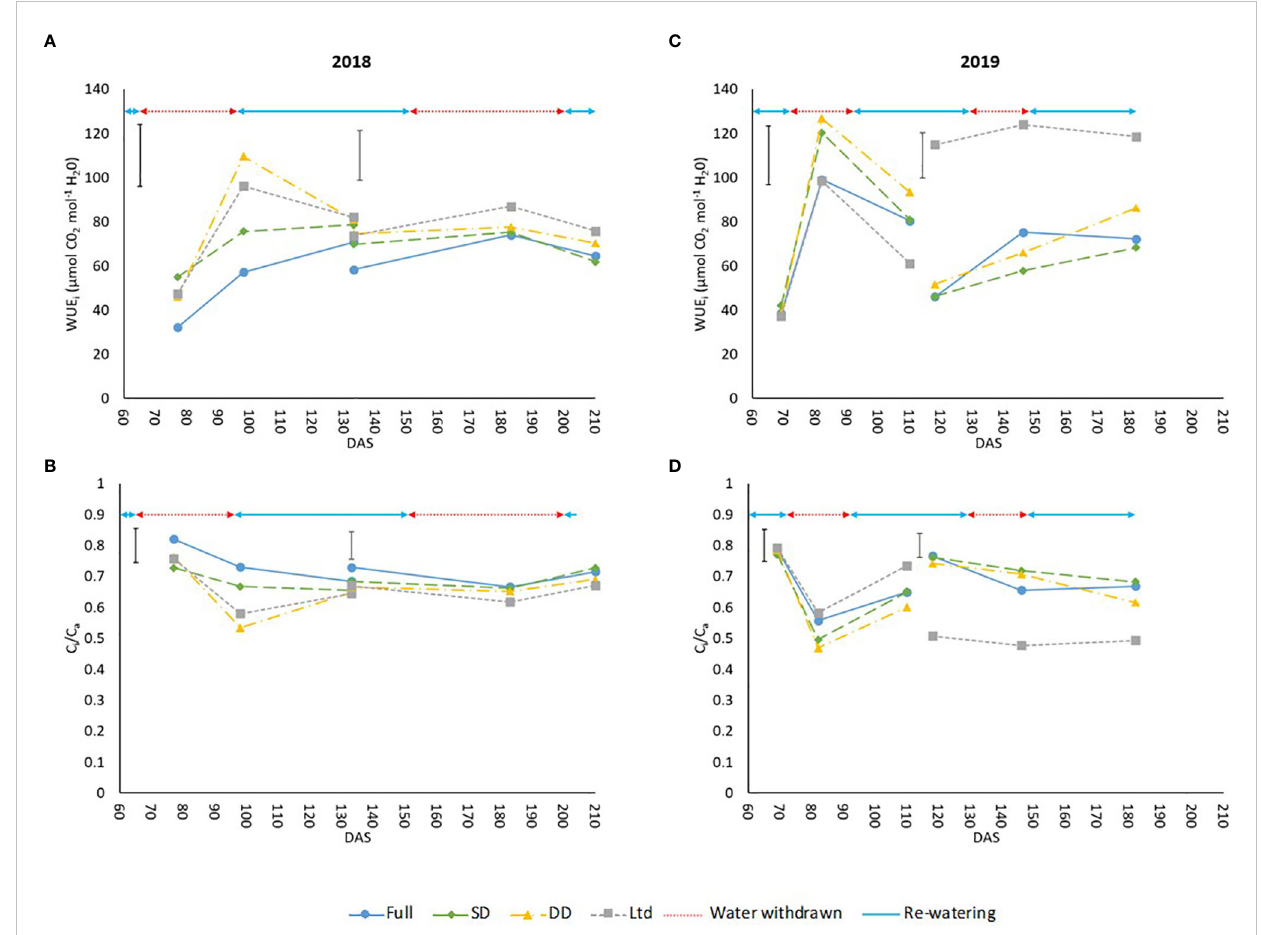
FIGURE 3 The intrinsic water use ef fi ciency (WUE i ) and ratio of intercellular to ambient CO 2 (Ci/C a ) of sugar beet grown under four irrigation regimes, measured using an infra-red gas analyser (Li6800, LiCor, Nebraska, US). Measurements were taken from 2 leaves Measurement leaf 1 covers the fi rst drought and measurement leaf 2 the second drought in 2018 and 2019. (A) leaf 1 (LSD=28.2 DF=190 P=0.004), leaf 2 (LSD=22.4 DF=191 P=0.004). (B) leaf 1 (LSD=0.110 DF=190 P=0.006), leaf 2 (LSD=0.088 DF=191 P=0.004). (C) leaf 1 (LSD=26.5 DF=220 P=0.003), leaf 2 (LSD=20.4 DF=255 P=0.022). (D) leaf 1 (LSD=0.104 DF=220 P=0.003), leaf 2 (LSD=0.079 DF=255 P=0.027). Error bars show time x irrigation LSD for all data points. ANOVA tables containing all the data points are available for WUE i and C i /C a in Supplementary Table S5 (2018) and Table S6 (2019). Irrigation regimes were a fully irrigated (Full), a continually water limited kept at approx. 50% fi eld capacity (Ltd), a single drought (SD) (2018 65-96 DAS and 2019 73 -92 DAS) and a double drought (DD) which was exposed to the single drought treatment plus an additional drought (2018 151-200 DAS and 2019 118-182